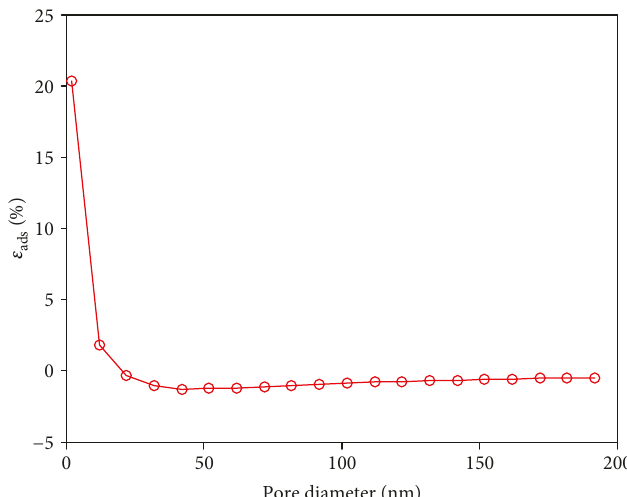
Figure 15: The e ff ect of the adsorbed layer on total apparent permeability (formation pressure = 20 MPa